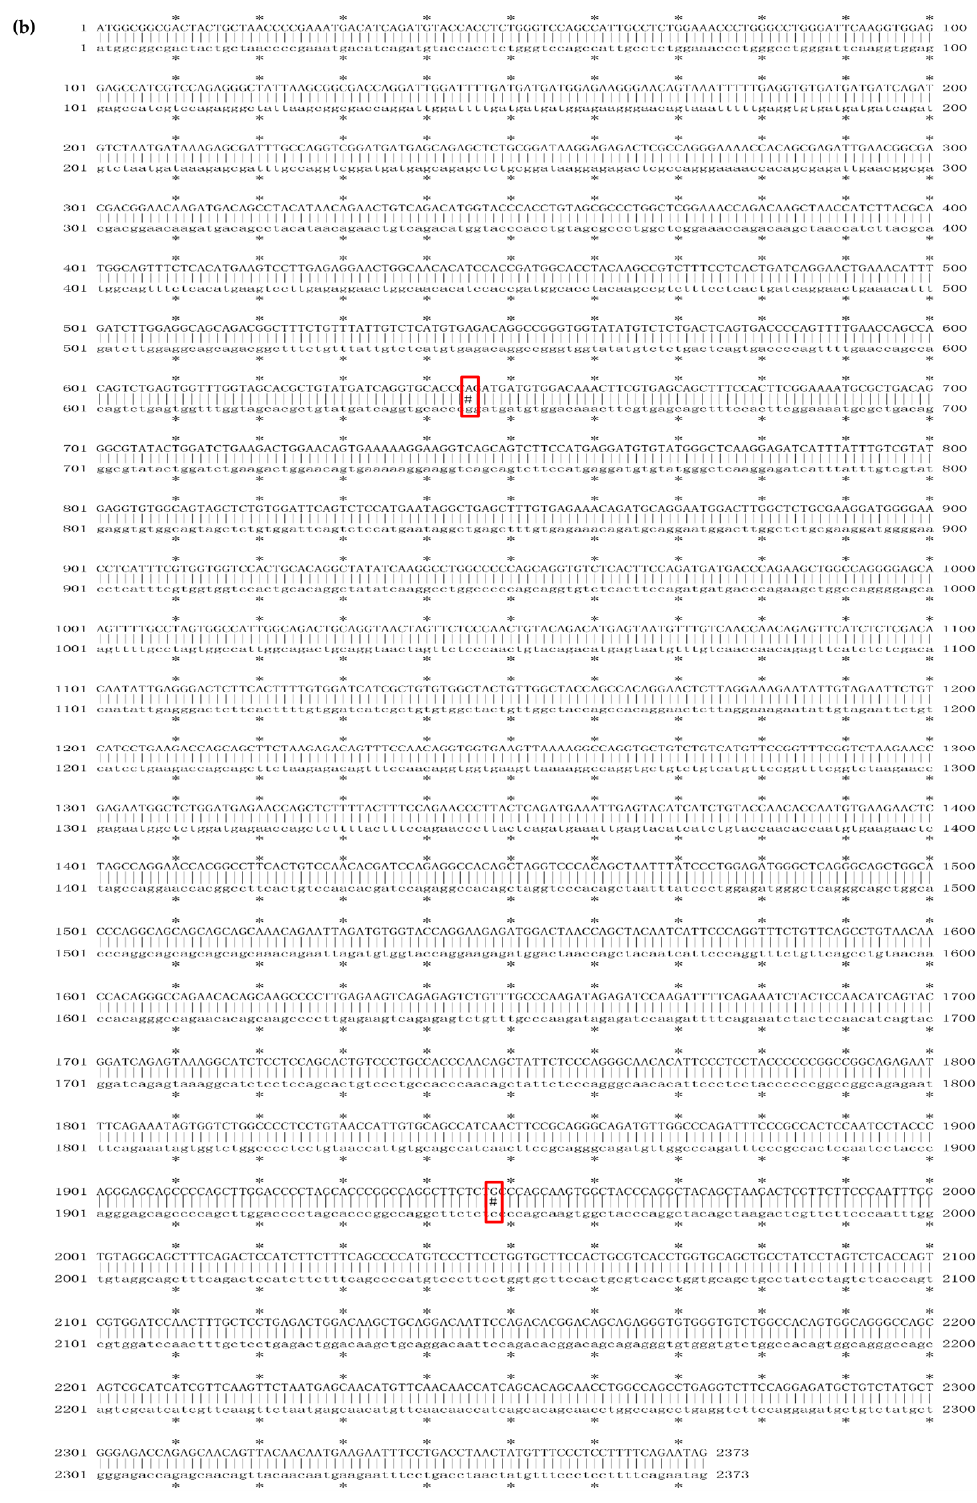
Figure 3. ARNT gene CDS sequence in Hu and Texel sheep: ( a ) Electrophoresis agarose gel of Hu sheep ARNT CDS PCR product, ( b ) CDS alignment of ARNT gene between the Hu sheep and Texel sheep. The top sequence is the Hu sheep ARNT CDS sequence, and the bottom sequence is the Texel sheep ARNT CDS sequence, and the two SNP mutations are in the red box, respectively. And add one * per 10 bases in Figure 3b.